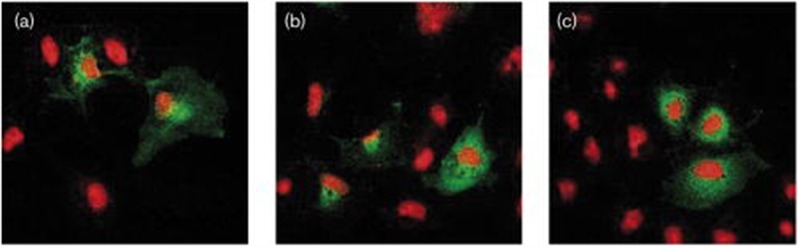
Confocal microscopy imaging of cysteinyl-leukotriene 1 (CYSLTR1) WT and variant receptors in transiently transfected cells. Cells were fixed and immunofluorescently stained with anti-CYSLTR1R antibody (green) followed by Alexa 488 goat anti-rabbit antibody (red) as described under Methods section. Superimposed images of immunoreactivity of (a) WT CYSLTR1 receptor, (b) Gly300Ser CYSLTR1 receptor variant or (c) Ile206Ser CYSLTR1 receptor variant, in basal condition. One representative experiment is shown (adapted from Thompson et al., 2007).